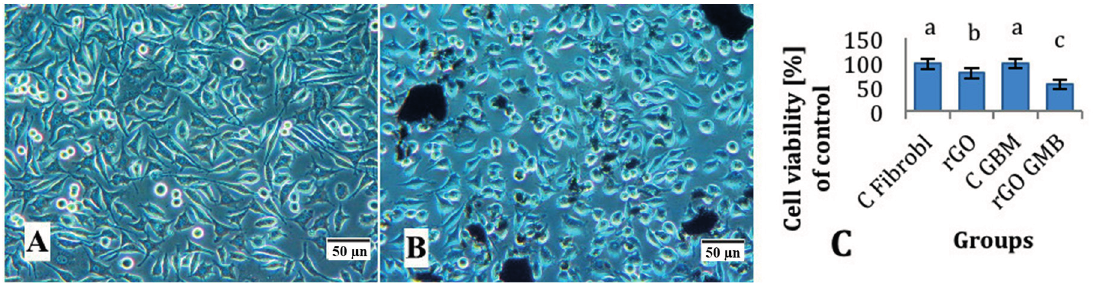
Figure 3. Morphology of L929 fibroblast cells in the control group ( A ); after treatment with reduced graphene oxide ( B ) and the viability of cells ( C ). Notes: Reduced graphene